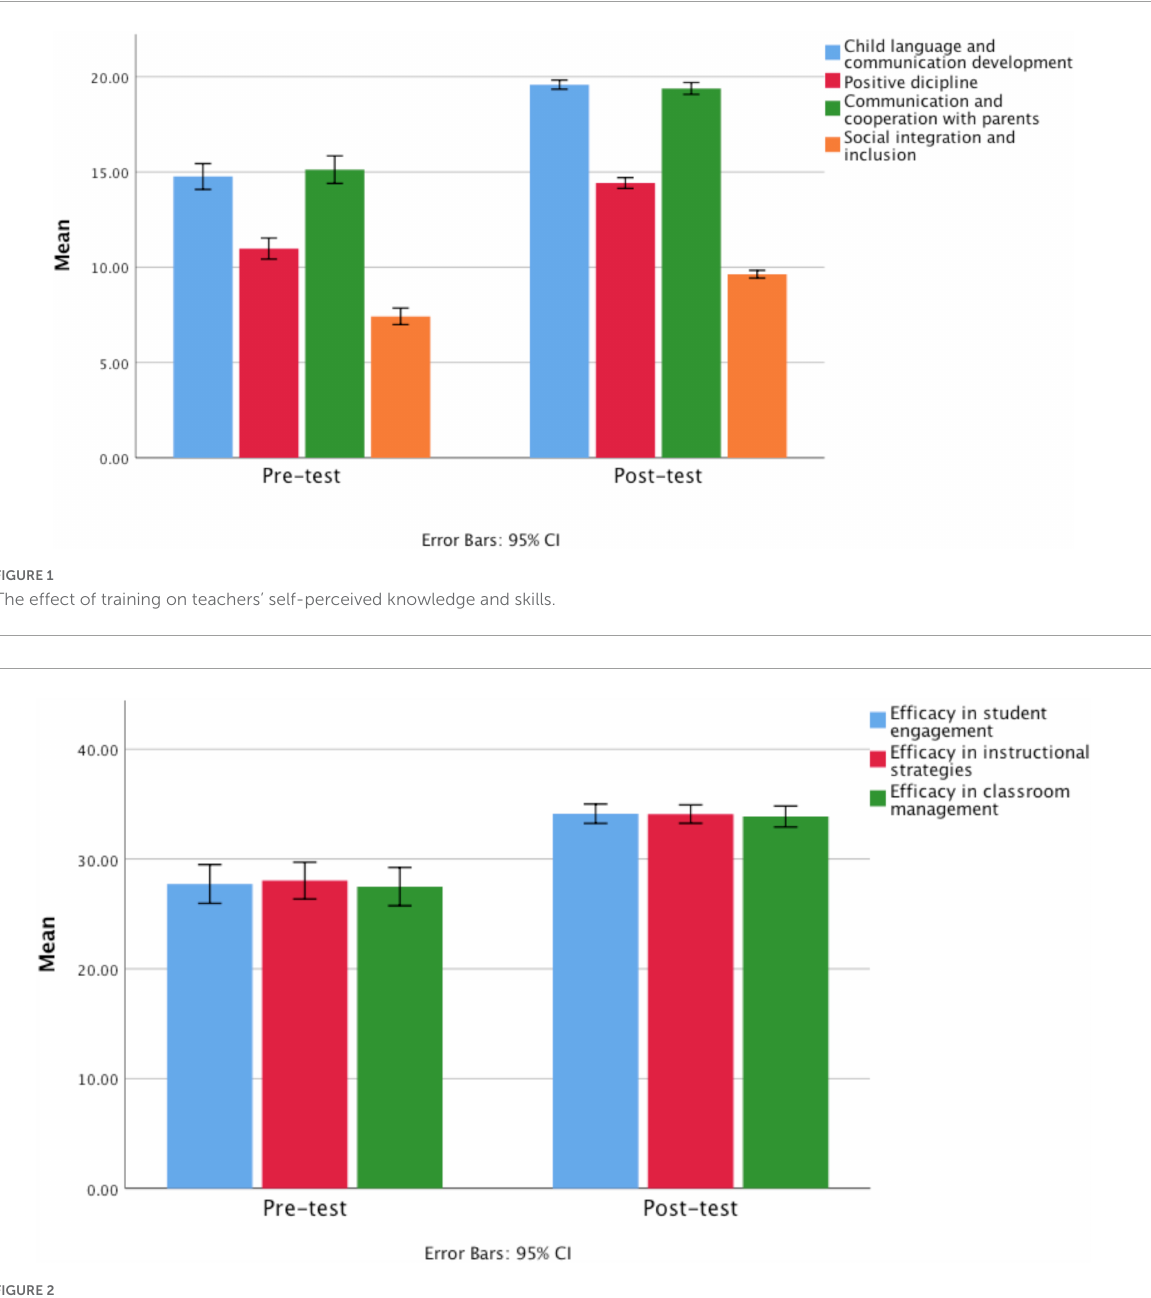
FIGURE2 The effect of training on teachers’